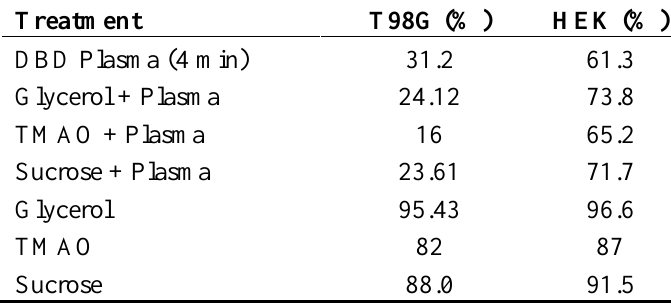
Table 3. Percentage viability after 24 h of treatment at lower concentration of osmolytes. T98G cells were treated with osmolytes at 0.1 mM concentration with or without DBD plasma for 4 min. All values are means of three independent